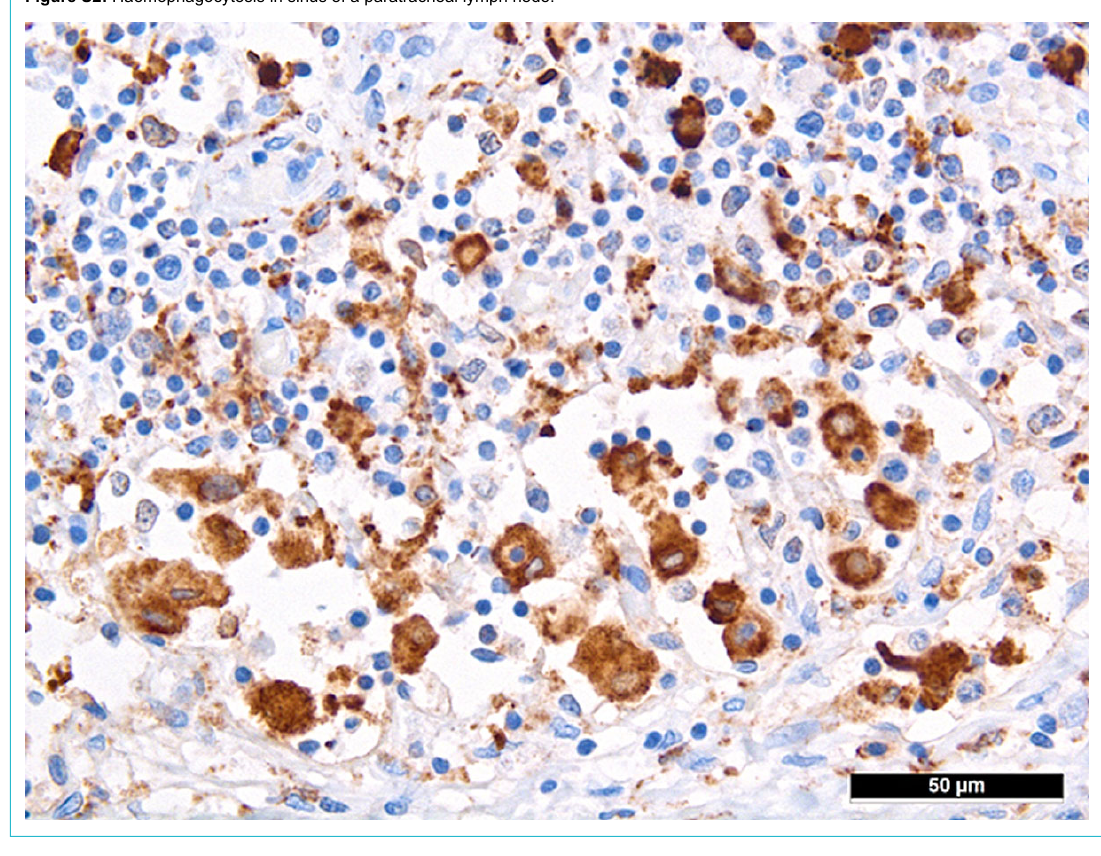
Figure S2: Haemophagocytosis in sinus of a paratracheal lymph node.